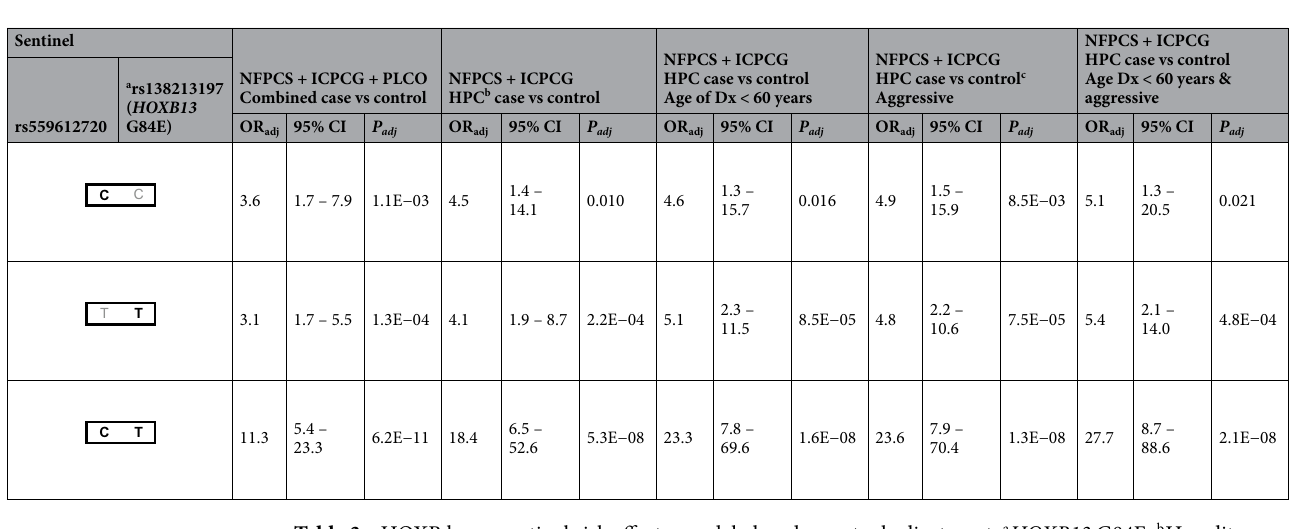
Table 3. HOXB locus sentinel risk effects, modeled under mutual adjustment. a HOXB13 G84E. b Hereditary prostate cancer cases are those with a family history of ≥ 3 total affected men; each evaluated case is from an unrelated pedigree. c Aggressive is defined: ≥ pT3, or N1, or M1, or Gleason ≥ 8, or PSA ≥ 20 ng/ml at diagnosis, or lethal prostate cancer. The denominator of odds ratios represents carriers of only non-risk alleles of both sentinels. The numerator of these odds ratios represents carriers of either, or both risk alleles (bolded). HPC, hereditary prostate cancer. Dx,